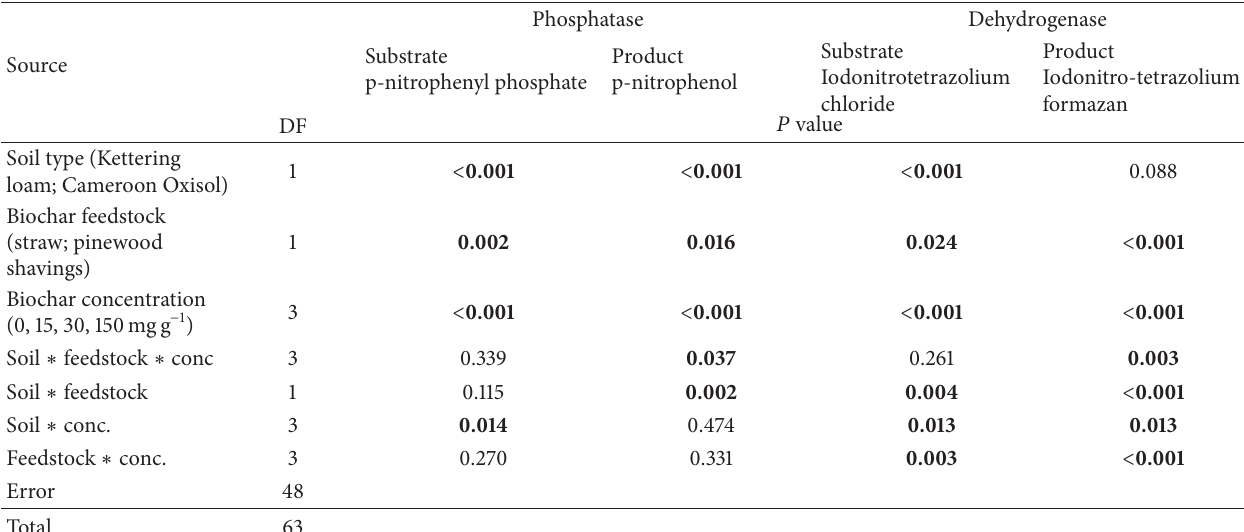
Table 2: Statistical evaluation of the effects of soil type, biochar concentration, and biochar feedstock and their interactions on the aqueous- phase concentration or extractability of enzyme assay substrates and products, respectively, used in soil dehydrogenase and phosphatase assays. The ANOVA was conducted using general linear model (Minitab 16) with ranked data ( 𝑛 = 4